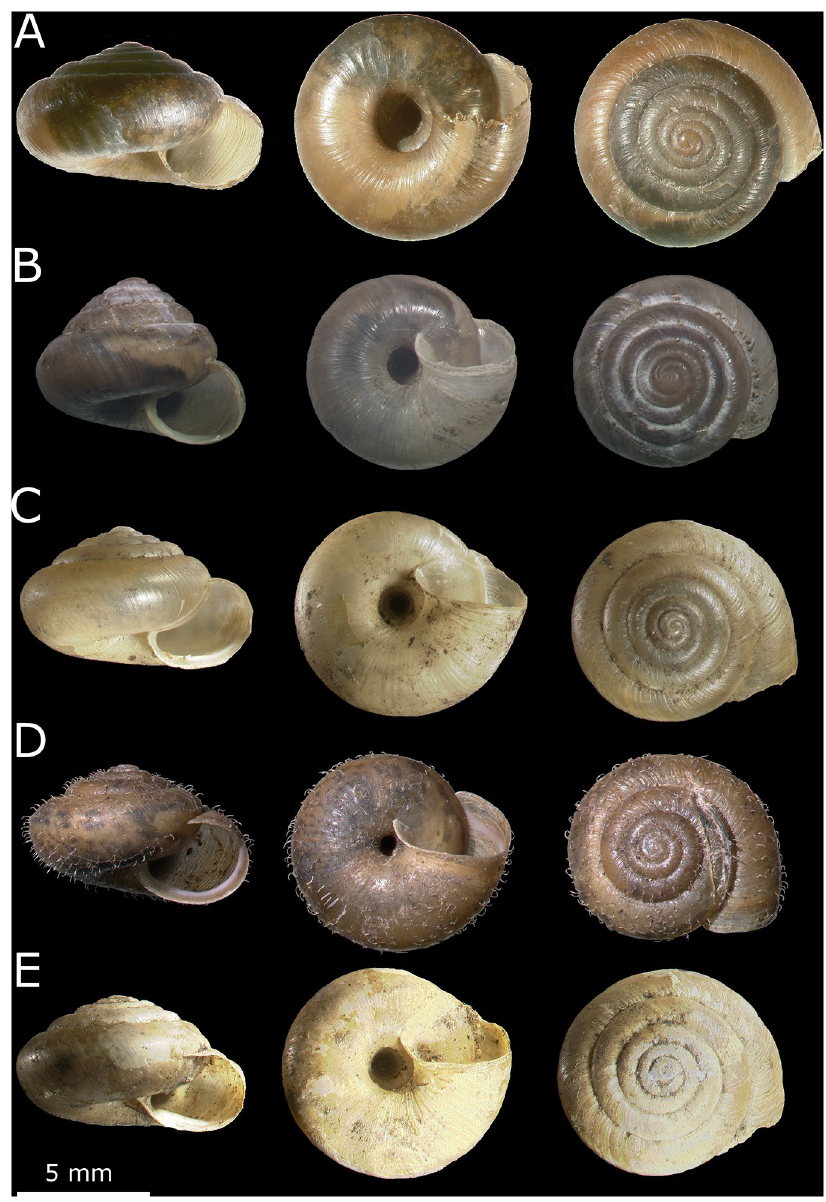
Figure 5. Shells of two Trochulus ecophenotypes: parental T. hispidus from wild habitat in Wrocław ( A ), the first generation of T. hispidus raised in laboratory ( B ); T. hispidus reared in garden in Wrocław ( C ); T. sericeus from wild habitat in Muszkowice ( D ); T. sericeus reared in garden in Wrocław ( E